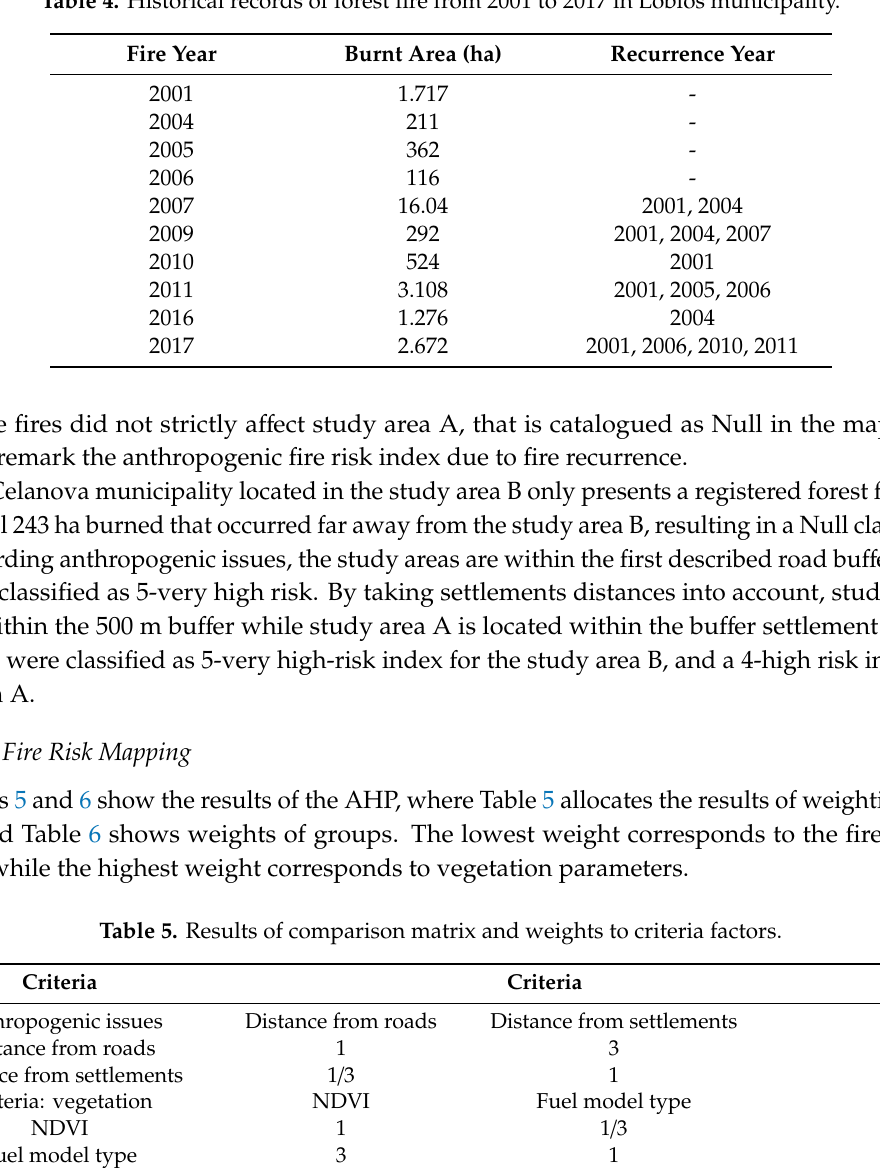
Table 4. Historical records of forest fire from 2001 to 2017 in Lobios municipality.